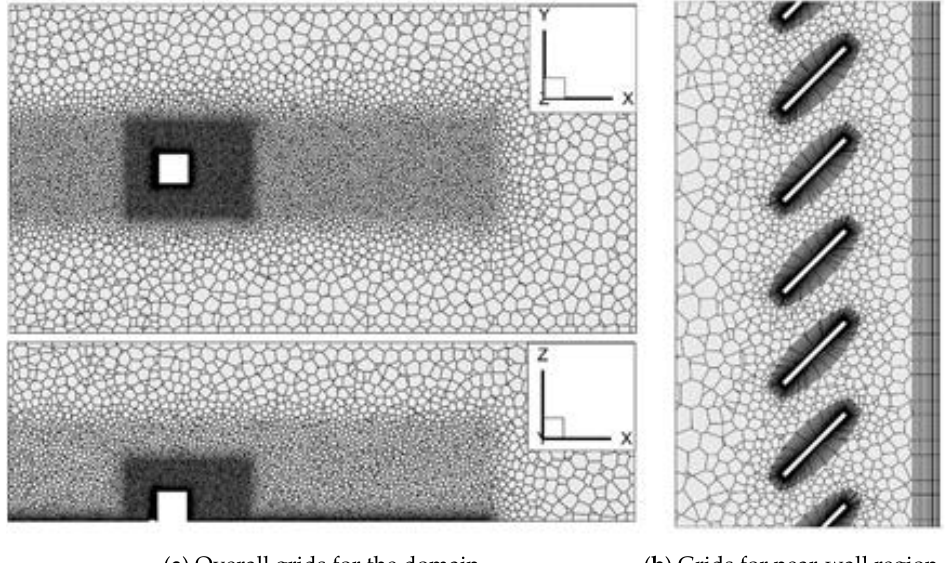
Figure 4. Grids for the simulation.